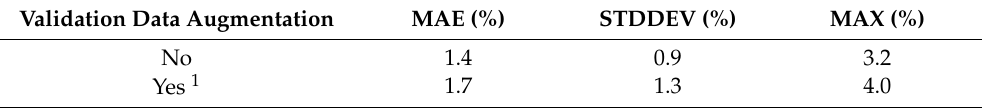
Figure 6. ( a ) Augmented and unaugmented voltage, current and temperature signals of validation dataset. ( b ) Estimation accuracy and error for augmented and unaugmented battery validation data. Please see Table 4 for detailed results. Table 4. Results showing effect of augmented versus unaugmented validation dataset. Validation Data